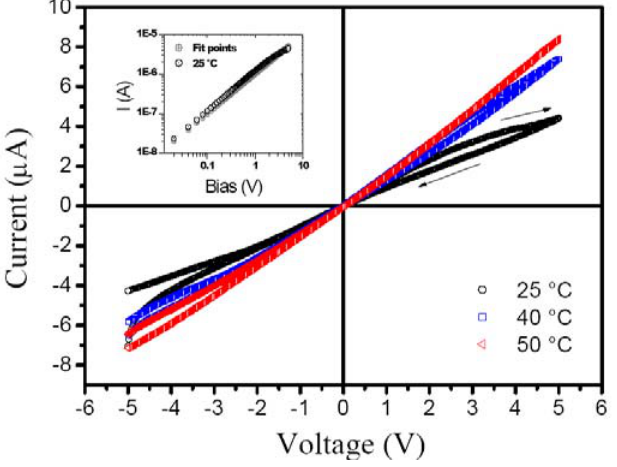
Figure 2. Current-voltage characteristics of a Au │ Polymers-dye blend │ Au sensor under variable temperature. The measurements were from –5.0 VDC until 5.0 VDC and back at 20 mV of scanning (see arrows). The inset corresponds to log-log curves of the Ohmic equation fitting I ( V ) characteristics at room